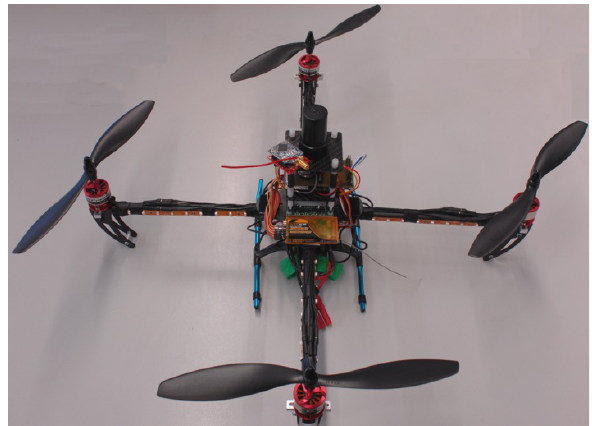
Figure 5. B110 receiver mounted to a Quadrocopter-platform